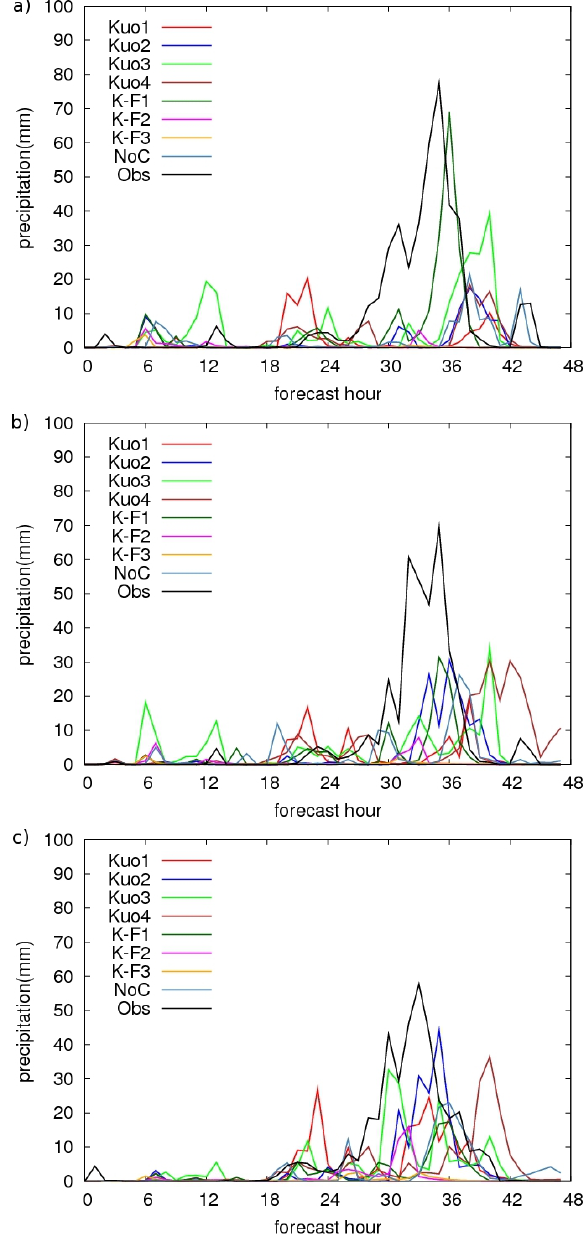
Fig. 9. Hourly evolution of RAMS forecasted and observed pre- cipitation: (a) Alcalal´ı station, (b) Isbert station, (c) Tollos station